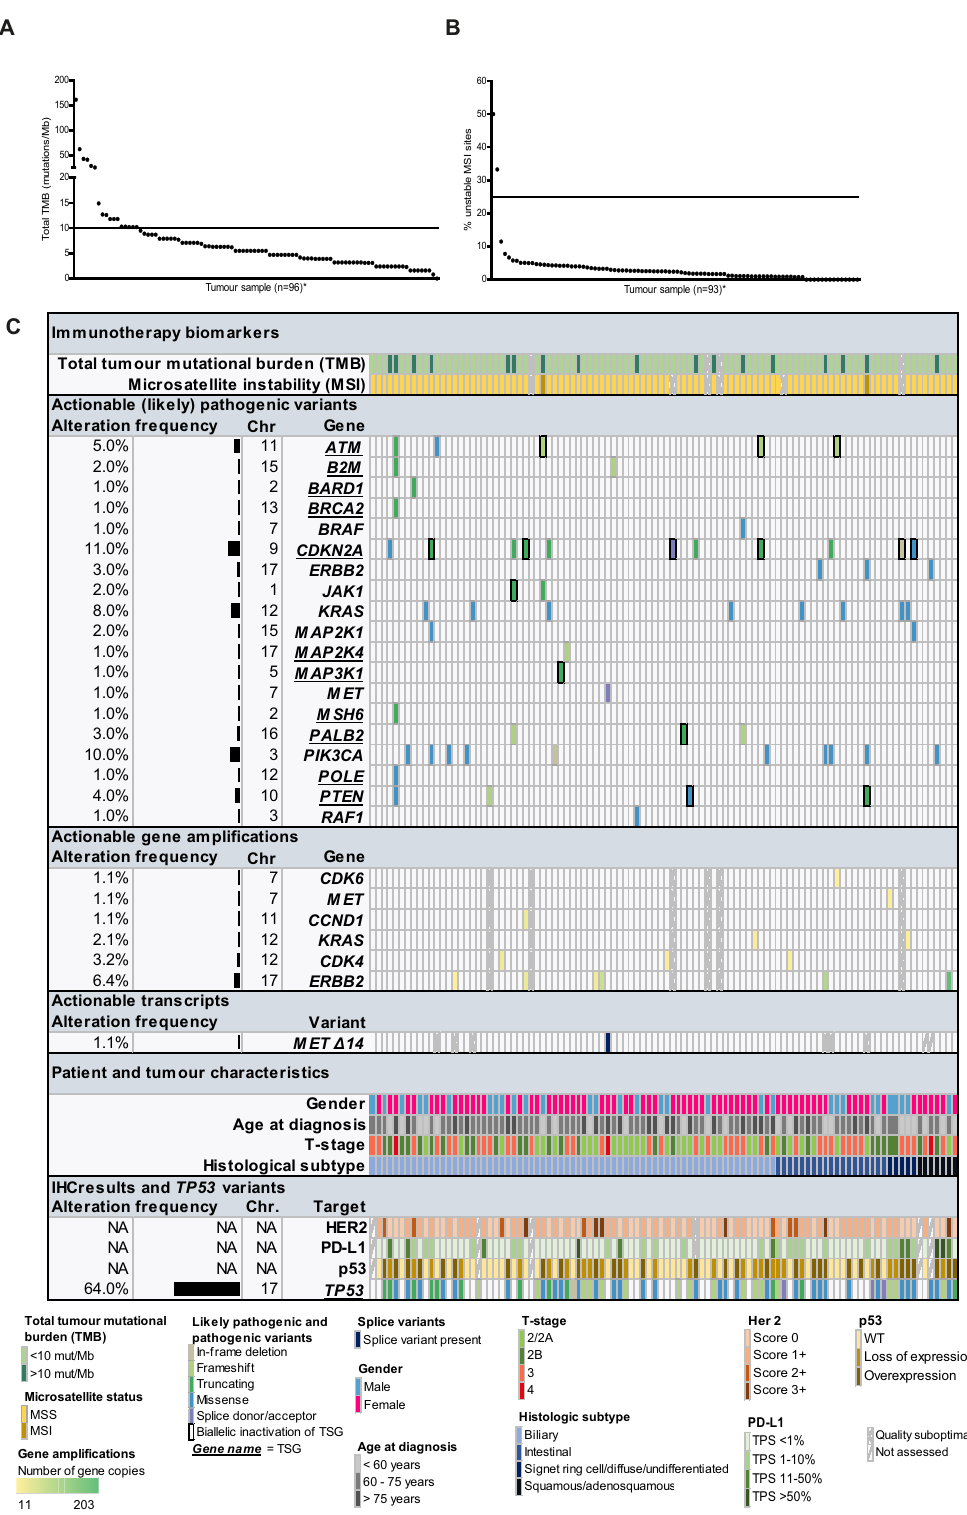
Fig. 3 Potential therapeutic targets in GBC. A Total tumor mutational burden (TMB), B Microsatellite instability (MSI), C Integrative overview of immunotherapy biomarkers (TMB, MSI), clinically relevant mutations (class 4 and 5), gene ampli fi cations, transcripts and immunohistochemistry results. NA not